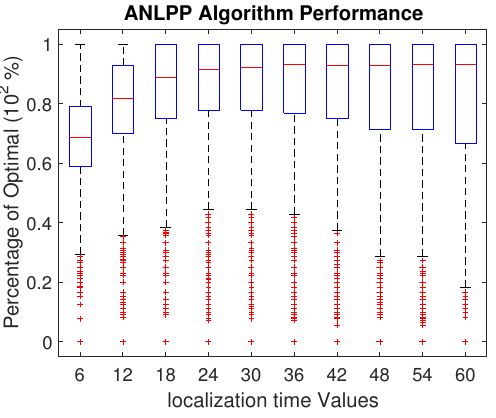
Figure 11. The impact of localization time on ANLPP performance, when tuned for localization time =